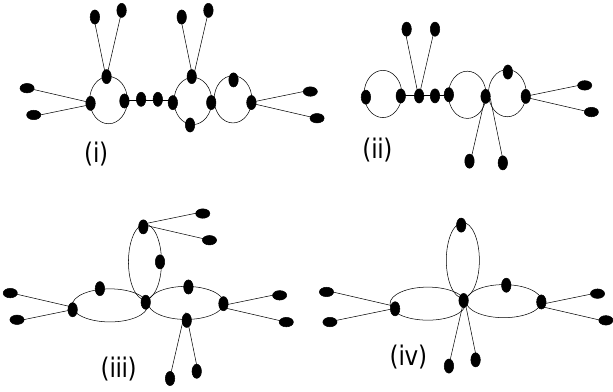
Figure 3: (i) B 6,2